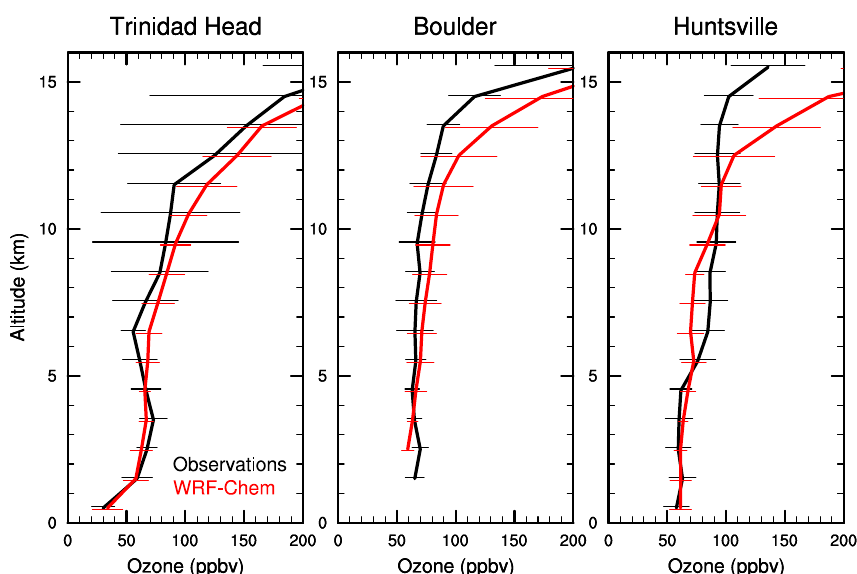
Fig. 8. Average O 3 profiles from ozonesondes (black lines) and WRF-Chem (red lines) for (a) Trinidad Head, California, (b) Boulder, Colorado, and (c) Huntsville, Alabama. The profiles are averages over the 15 July to 6 August 2006 when ozonesondes were launched. The horizontal lines indicate the standard deviations for each of the